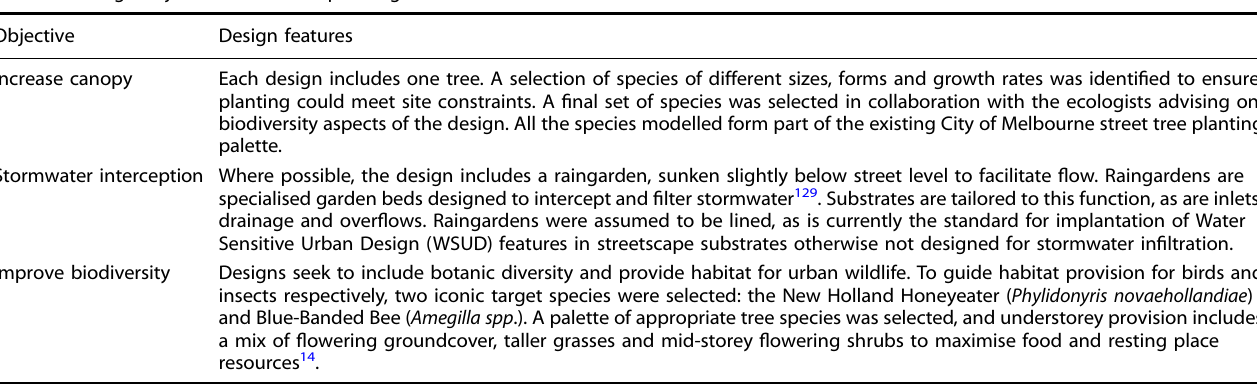
Table 2. Design objectives and corresponding